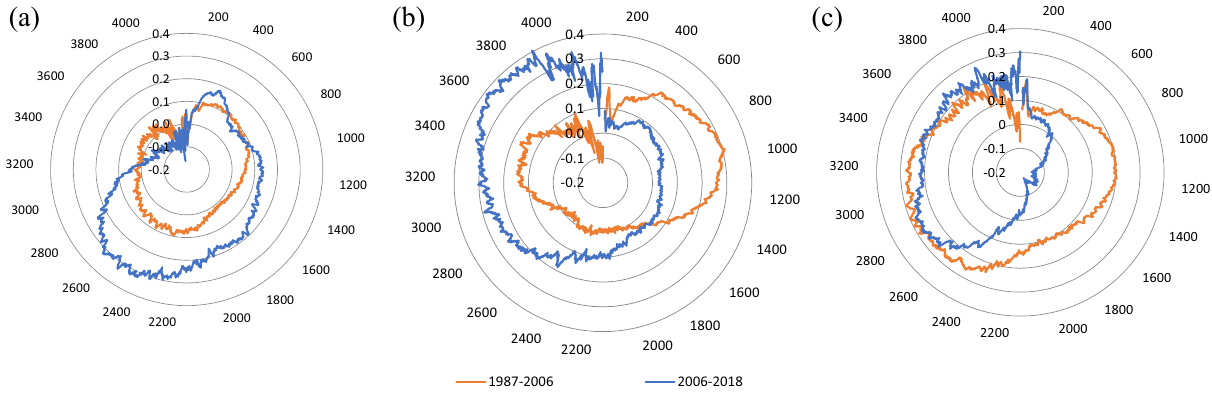
Figure 5. The correlation coefficient ( a ) between NDVI and precipitation, ( b ) between NDVI and temperature and ( c ) between NDVI and reference evapotranspiration climate factors under different elevation in Qin Mountains. The correlation coefficient between NDVI and hydro-climatic factors evaluated based on the pearson correlation method, which also available in the Google Earth